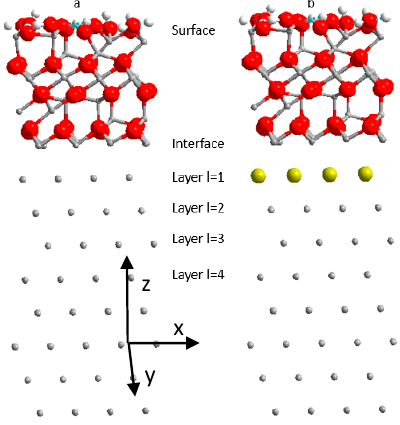
Figure 1. Slab model ( a ) Aluminium oxide supported by pure aluminium; ( b ) Aluminium oxide supported by an alloy with a full layer of copper in position l = 1. Aluminium atoms are in grey, copper atoms in yellow, oxygen atoms in red and hydrogen atoms in white.